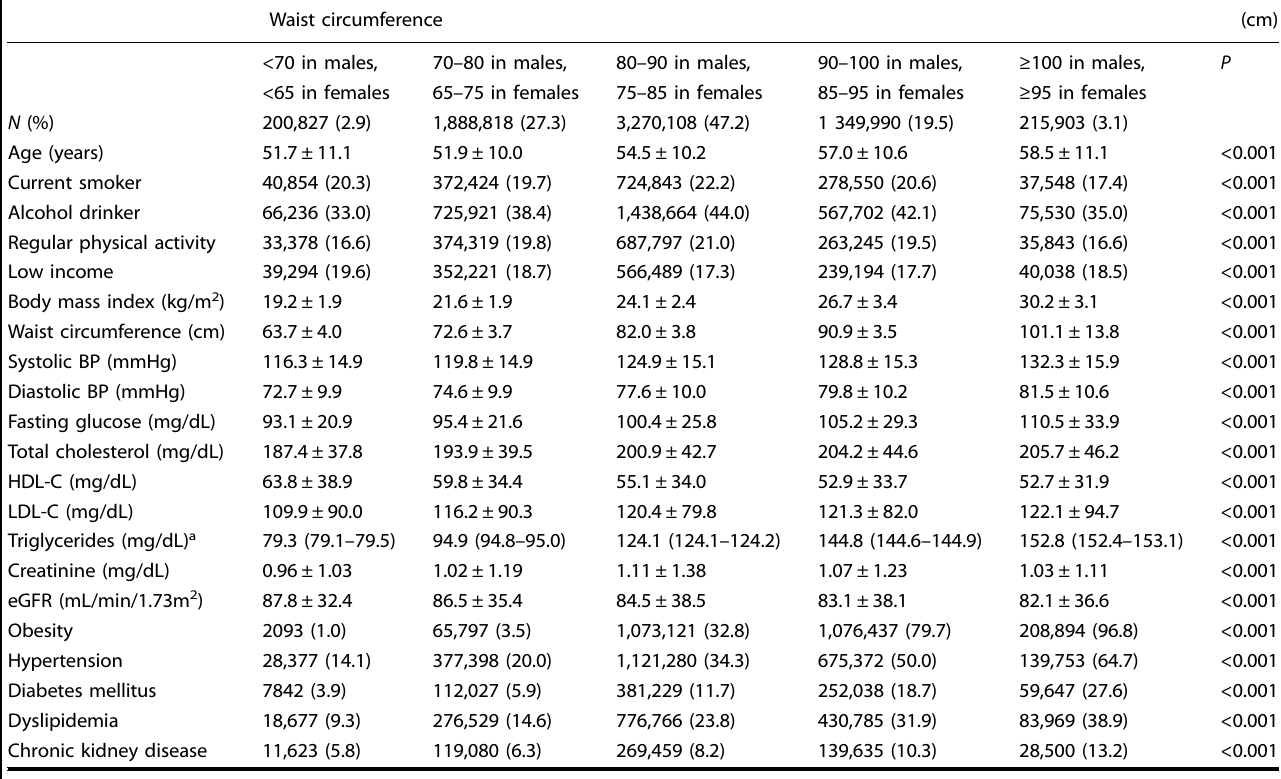
Table 1. Baseline characteristics of the study